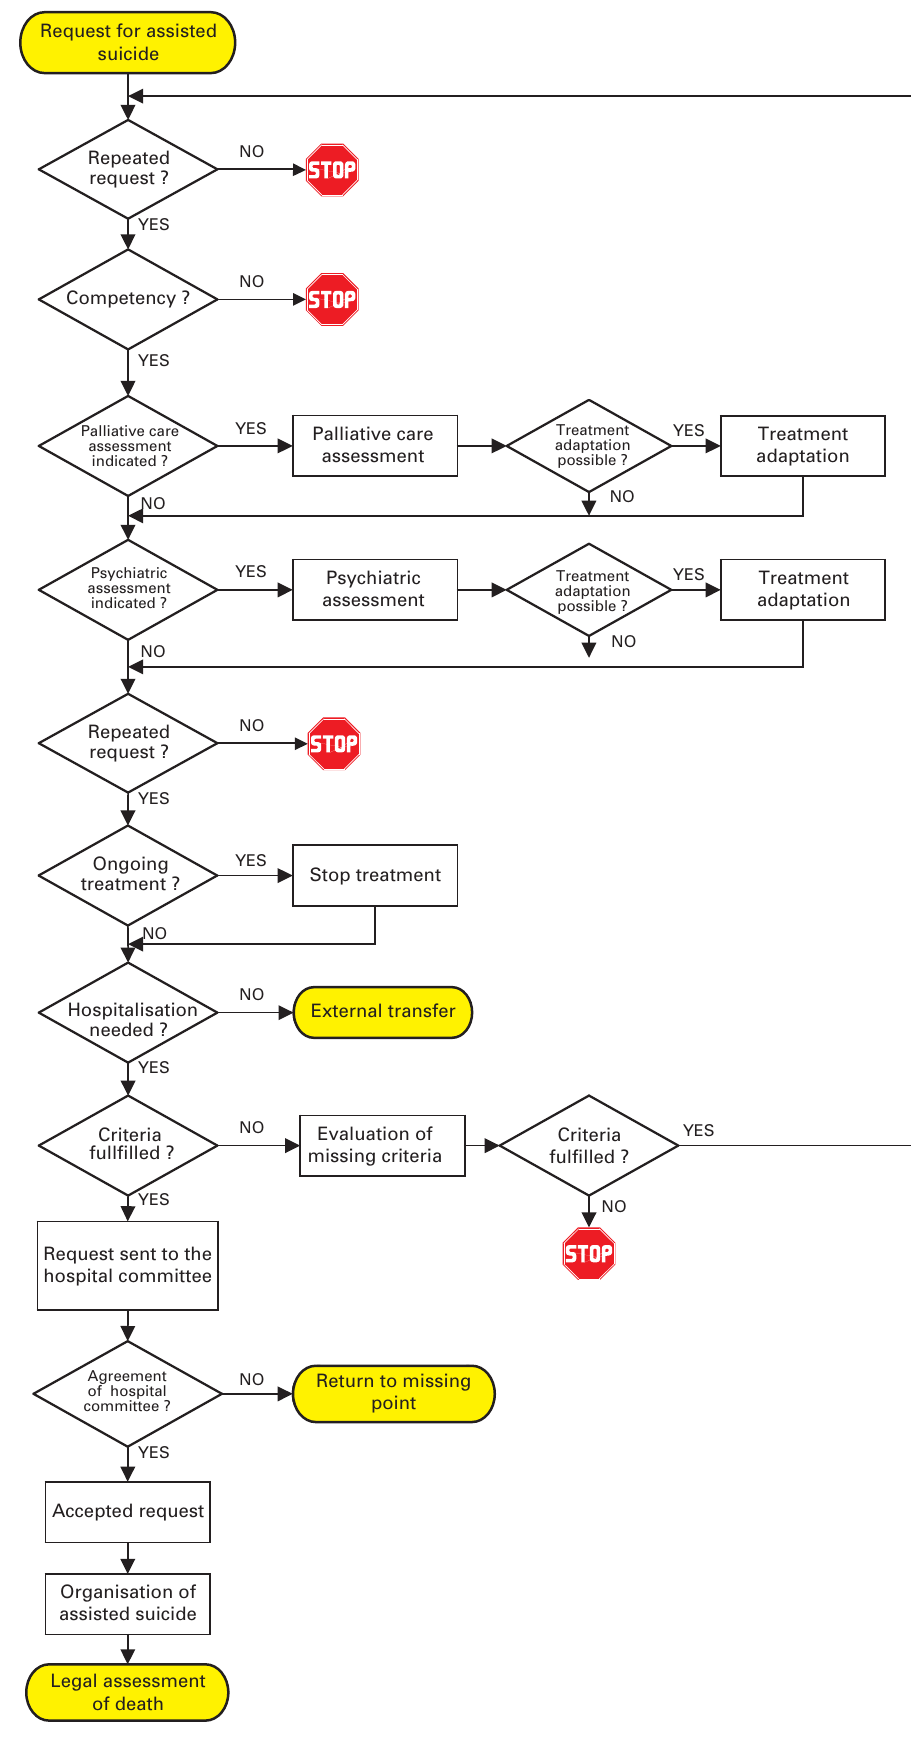
Flow chart for evalua- tion of requests for assisted suicide at the